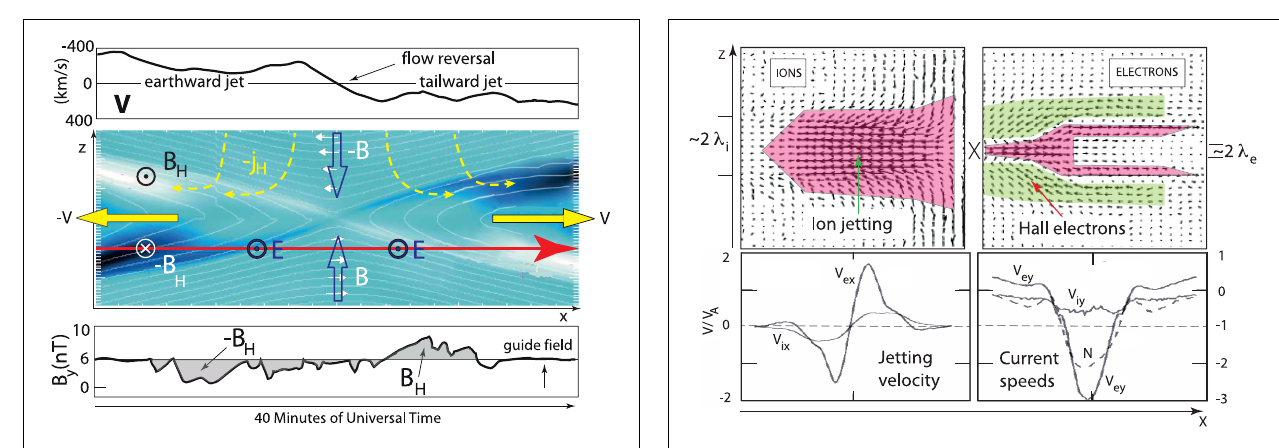
FIGURE 7 | Particle-in-cell simulations with small mass ratio m i / m e = 25 (simulation data after Pritchett [138] courtesy American Geophysical Union). Top panels: Velocities near the X line. Left: Left half (negative x ) of space for ion velocity. Ions flow in from positive and negative z before becoming diverted to negative x by jetting from reconnection site in a region of width in z proportional to λ i . Right: Right half (positive x ) of space for electron velocity. Electron inflow continues across the ion inertial region until close to the center of the current sheet mapping the electron Hall current flow. In the current sheet center the electron velocity turns around by close to 180 ◦ to participate in the plasma jetting (in this half plane into positive x ) in a region of width proportional to λ e . Bottom: Jetting and currents exhibiting different ion and electron dynamics. Left: Electron and ion jetting velocities. Ion mass flow in jets barely reaches 0 . 5 V A . Electron jetting comes up to ∼ 1 . 7 V A . Right: Current speeds indicate deceleration for the ions at the X point. Electron velocities are inflected such that the current in the center is carried about solely by